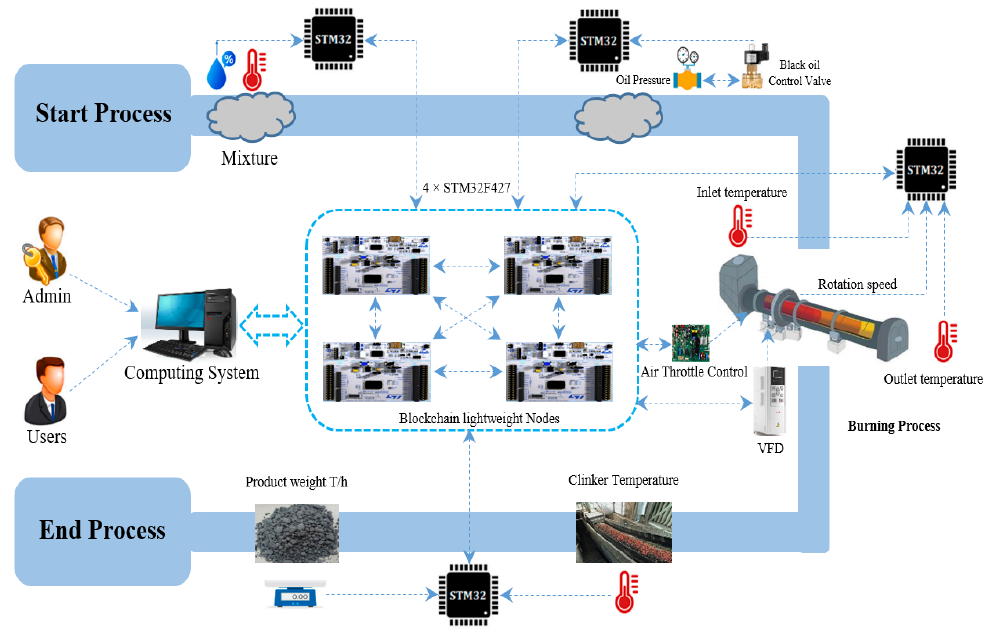
Figure 4. A blockchain-based cement production